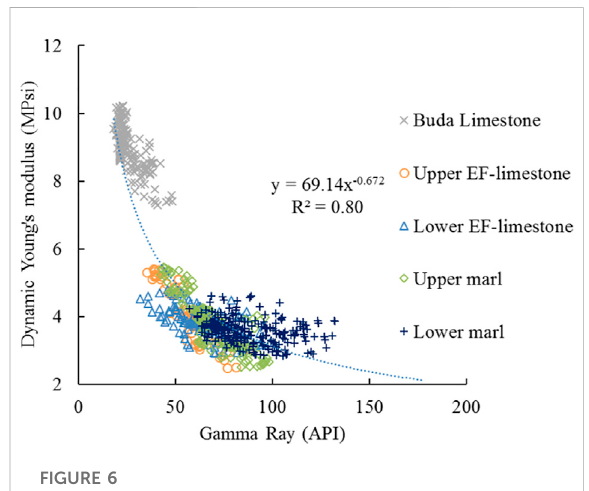
FIGURE 6 Correlations of dynamic Young ’ s Modulus and gamma ray in different layers.